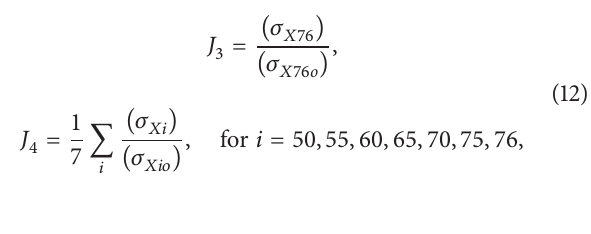
are defined. These response quantities with control measures are normalized by the response quantities of the uncontrolled